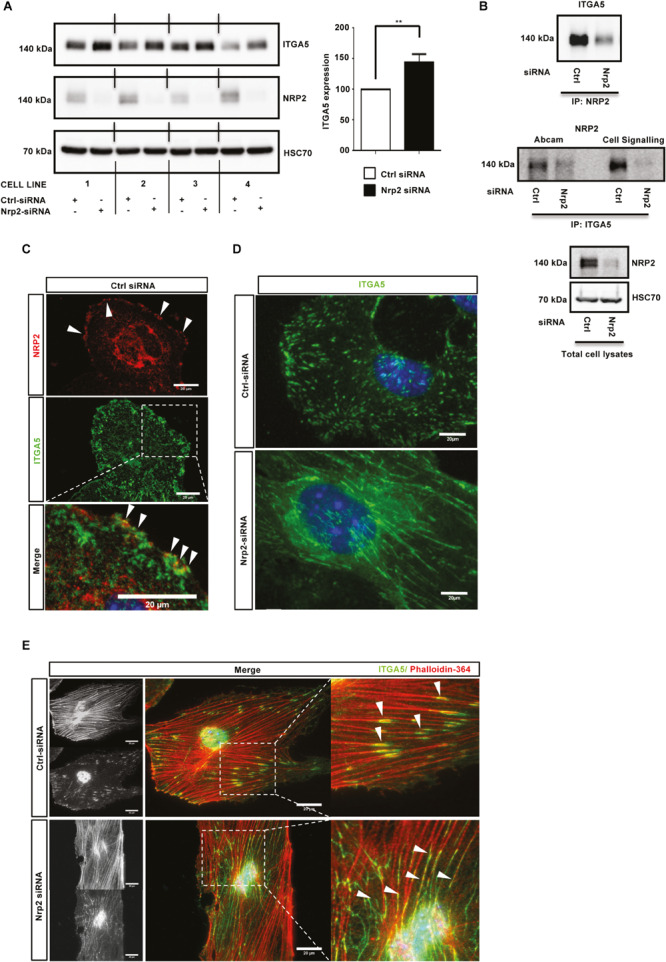
NRP2 regulates ITGA5 expression in ECs. (A): siRNA-transfected ECs from four different clones were seeded onto FN and incubated for 48 h. EC extracts were immunoblotted using antibodies to ITGA5, NRP2, and HSC70. Left panel shows Western blot image, right panel shows densitometric analysis of ITGA5 band intensities normalized against HSC70 and obtained using ImageJTM. **P < 0.01. (B): siRNA-transfected ECs were seeded onto FN and incubated for 48 h. Left panel: EC extracts were immunoprecipitated by incubation with protein-G Dynabeads® coupled to a NRP2 antibody. Middle panel: EC extracts were immunoprecipitated by incubation with protein-G Dynabeads® coupled to two different ITGA5 antibodies (as indicated). Immunoprecipitated complexes were subjected to Western blot analysis using antibodies against ITGA5 and NRP2, respectively. Right panel: NRP2 silencing was confirmed by subjecting the total cell lysate to Western blot analysis and incubating blots in antibodies against NRP2 and HSC70. (C): Control siRNA-transfected ECs were prepared as described in Figure 2D legend. Fixed ECs were incubated in primary antibodies against NRP2 and ITGA5. Images were captured using a Zeiss AxioImager M2 microscope at 63x magnification. Arrows indicate co-localization of NRP2 and ITGA5. (D): siRNA-transfected ECs were prepared as described in Figure 2D legend, however, ECs were allowed to adhere overnight prior to fixation. ECs were incubated in primary antibody against ITGA5. (E) siRNA-transfected ECs were prepared as described in (D), however, fixed cells were incubated in ITGA5 primary antibody and phalloidin-364. Arrows indicate localization of ITGA5 with actin filaments. Image panels shown in (C–E) are representative of n ≥ 10 cells per condition/treatment.